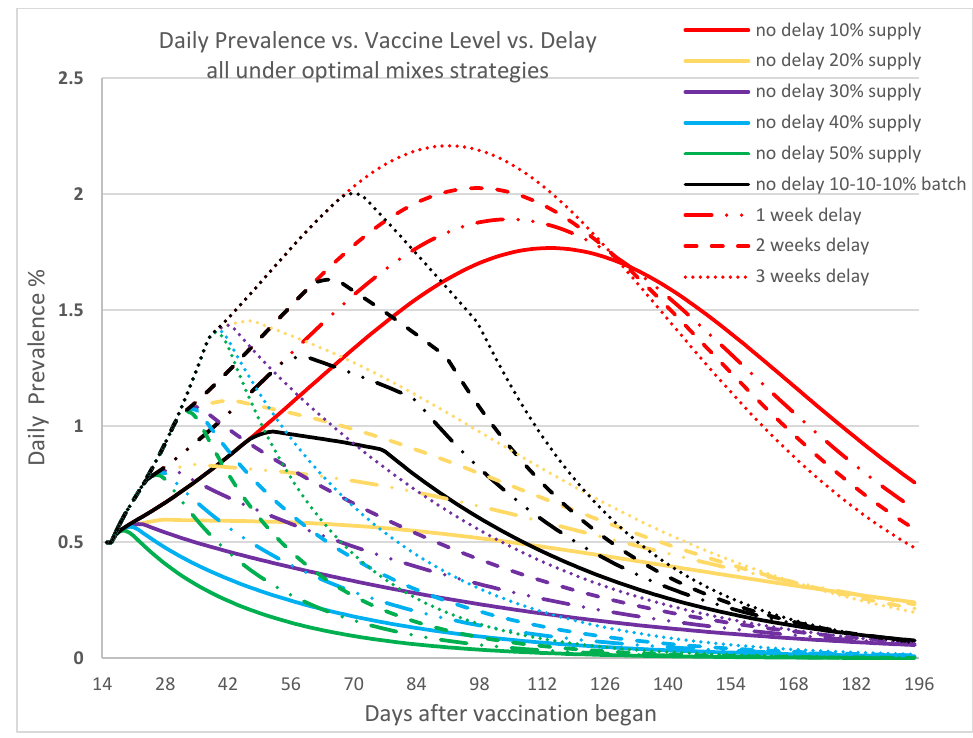
Figure 6. In this figure we show daily prevalence of COVID-19, resulting from various vaccine supply levels when vaccination begins on time, or with delays of one week, two weeks, and three weeks, and is dispensed according to the associated optimal mixed strategy. Here, 𝑅 0 = 1.2 and the initial infected population is 0.5%. The x -axis represents the number of days since vaccination began. The colors correspond to the vaccine levels, the line types correspond to the delay timeline.